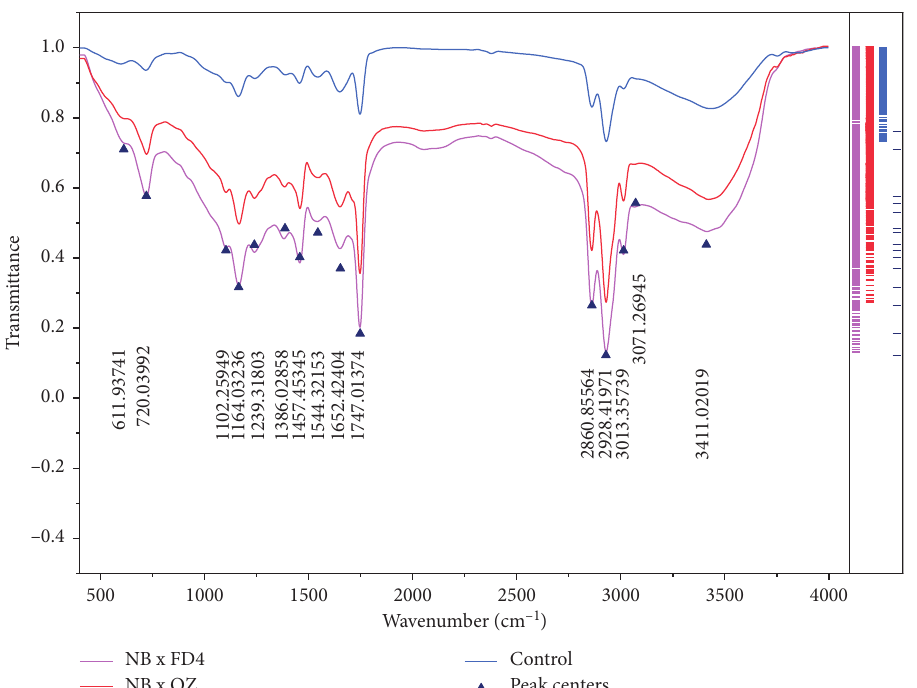
Figure 3: ATR-FTIR spectrum of fig seeds showing major peaks in the range of 4000–450cm − 1 . FD4:Frond d’Oued N ° 4; OZ: Ouzidane.